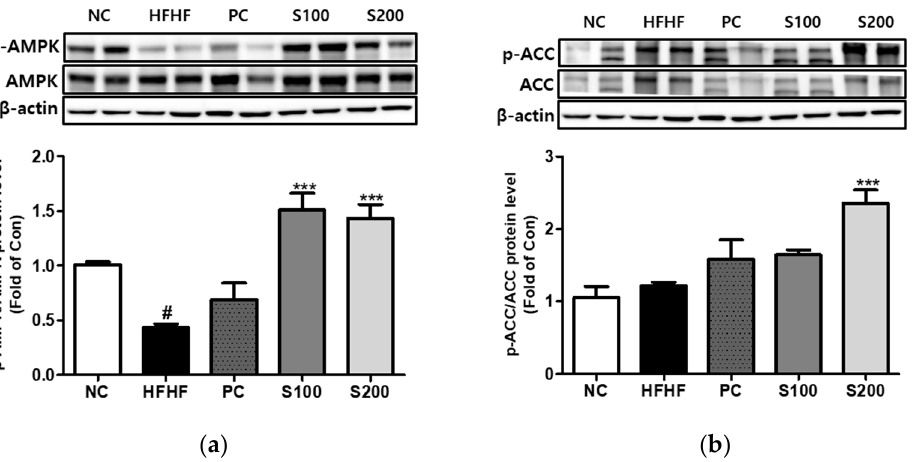
Figure 7. Effects of Bombyx mori (SW) on the expression of AMPK and ACC signaling in HFHF-fed mice. The expression of p-AMPK/AMPK ( a ) and p-ACC/ACC ( b ) were quantified by Western blot analysis. AMPK and ACC were used as a protein loading control of phosphorylated AMPK (p-AMPK) and phosphorylated ACC (p-ACC), respectively. β -actin was used as a protein loading control. NC, normal control; HFHF, 45% high fat diet with 10% fructose in the drinking water; PC, positive control (HFHF diet with 1% silymarin); S100, HFHF diet with SW (100 mg/kg/day); S200, HFHF diet with SW (200 mg/kg/day). The results from three independent experiments are expressed as the means ± SE. # p < 0.05 vs. NC; *** p < 0.001 vs. HFHF.